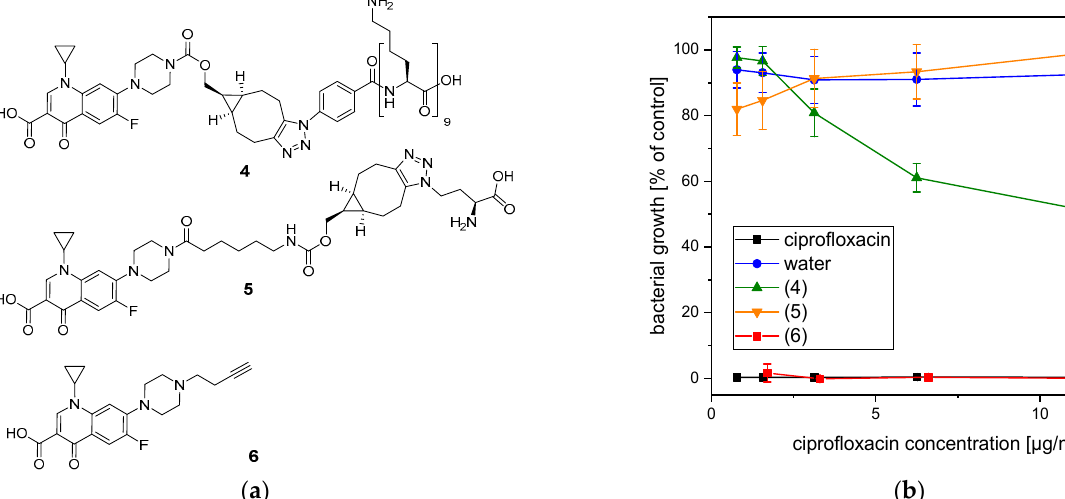
Figure 6. Bacterial growth in the presence of ciprofloxacin modifications. ( a ) Chemical structures of the ciprofloxacin modifications 4 , 5 , and 6 . ( b ) Percentage growth of S. aureus (mean ± SD) in the presence of different concentrations of ciprofloxacin modifications ( 4 , 5 , 6 ), unmodified ciprofloxacin, or water.